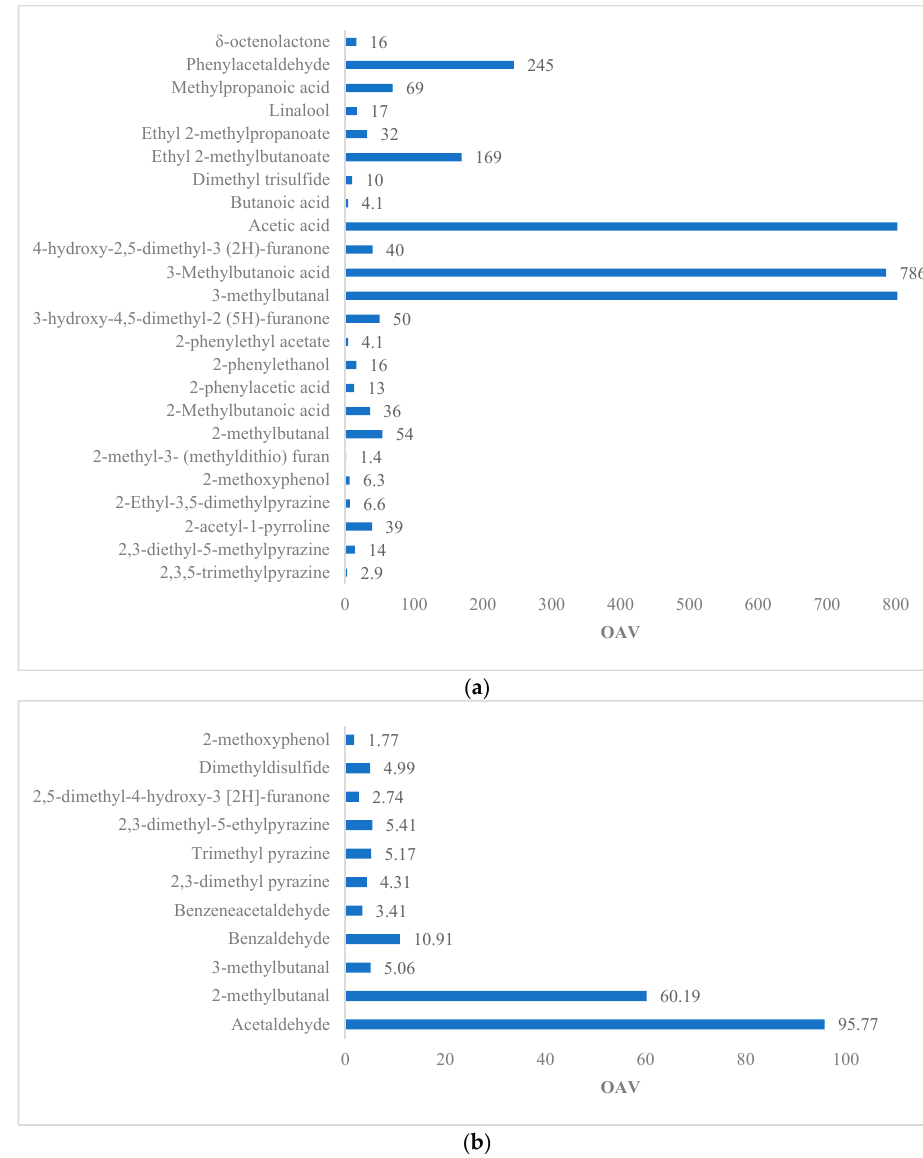
Figure 3. Volatile compounds profile present in the roasted beans determined by ( a ) [6] forastero roasted cocoa beans, and ( b ) [21] forastero roasted cocoa